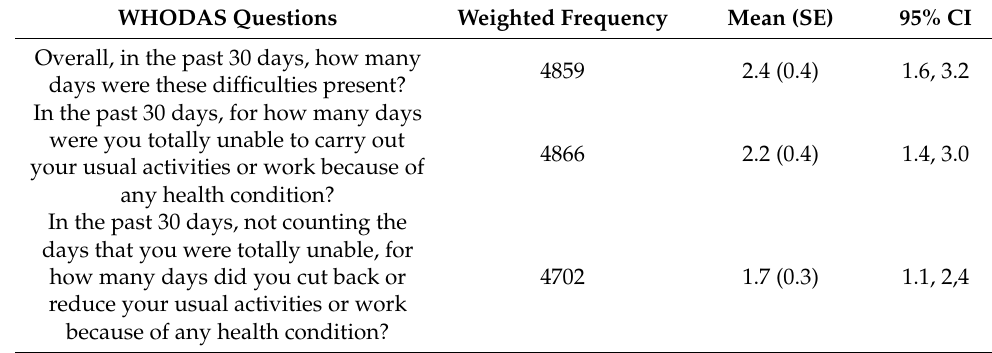
Table 3. Impact of disability from drowning incident on ability to carry out daily